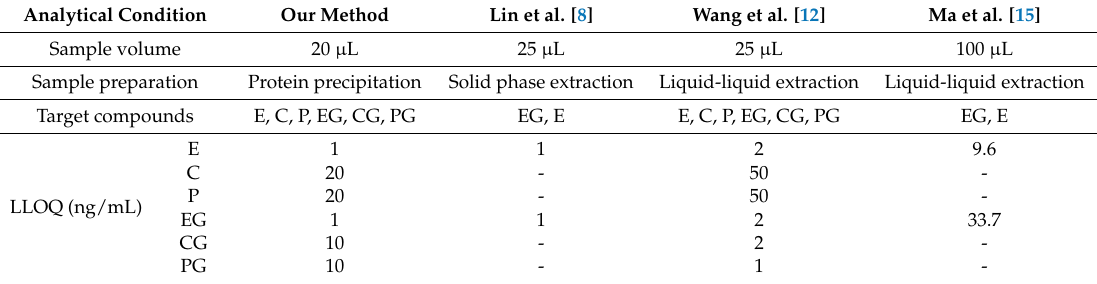
Table 6. Comparison with reported analytical methods for aglycones and glycosides of anthraquinone. Analytical Condition Our